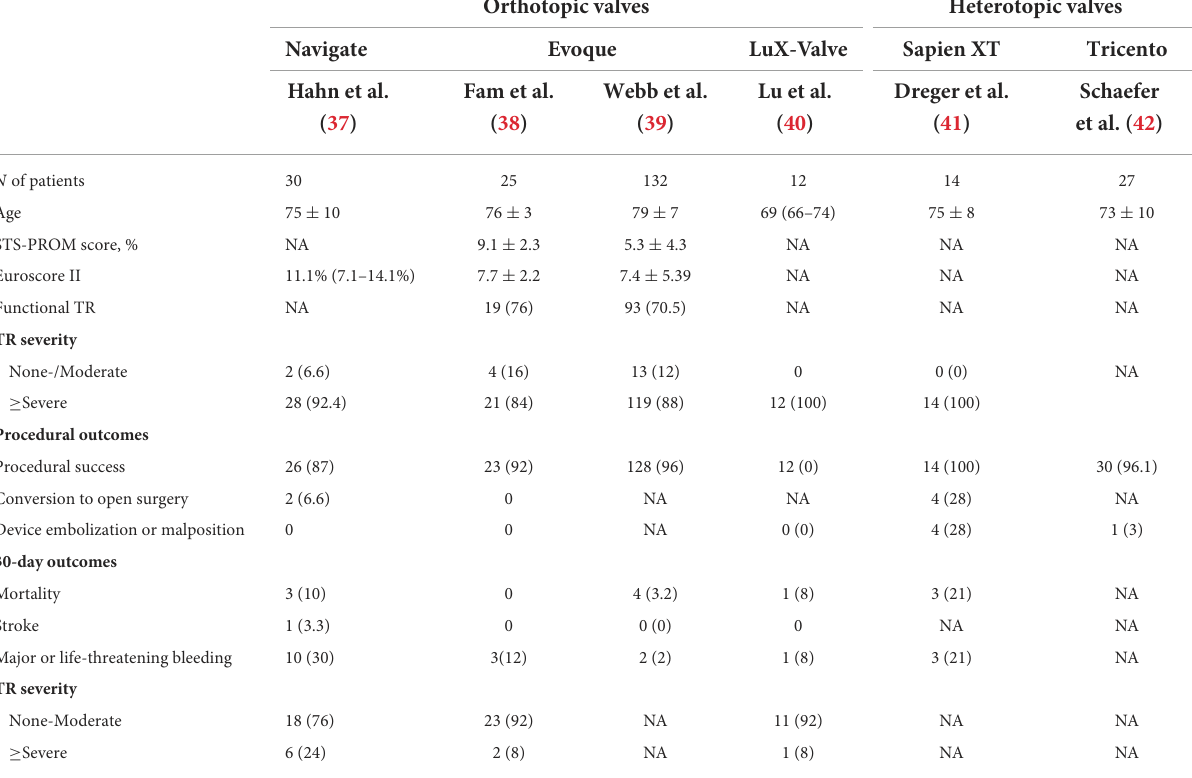
TABLE 4 Baseline and procedural characteristics and 30-day outcomes of patients undergoing TTV